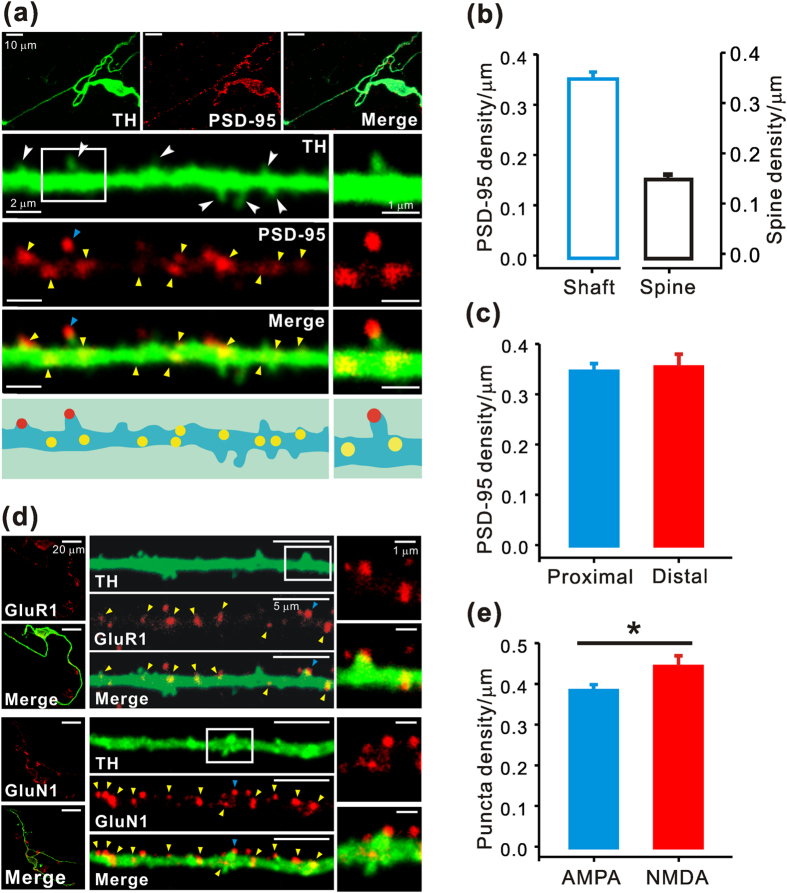
Molecular identification of glutamatergic synapses in dendrites of the SNc dopamine neurons.(a) Double immunostaining with antibodies specific for TH and PSD-95 in very gently dissociated dopamine neurons. Top, TH-positive (green), PSD-95-labeled (red), and overlapped images of a dopamine neuron (merge). Second to fourth lanes, expanded fluorescence images from a representative dendritic region. Bottom, images showing a dendritic shaft and PSD-95 synaptic sites. Arrowheads indicate PSD-95 fluorescence puncta in spines (blue) and shafts (yellow). Right, high-magnification images of the dendritic segment marked by a white box (left) show PSD-95 puncta in both dendritic spines and shafts. (b) PSD-95 density in the dendritic shaft, calculated from 12 dendrites in 10 cells. Error bar indicates SEM. Right, the spine density was redrawn from Fig. 2b,c for comparison. (c) Densities of PSD-95 puncta in the proximal dendritic shafts (<80 μm from the soma; n = 12) and distal dendritic shafts (>80 μm from the soma, n = 12). Error bars indicate SEM. (d) Distribution of AMPA receptors and NMDA receptors in the dendritic spines and shafts of SNc dopamine neurons. Double immunostaining of dissociated dopamine neurons with TH and either GluR1 for AMPAR or GluN1 for NMDAR. TH (green), GluR1 or GluN1 (red), and their overlapped images (merge) are presented. Arrowheads indicate GluR1 and GluN1 fluorescence puncta in spines (blue) and dendritic shafts (yellow). Dendritic regions containing a single spine marked by the white boxes are presented on the right. (e) GluR1 puncta (from 27 dendrites of 18 cells) and GluN1 puncta (from 17 dendrites of 10 cells) measured only in the dendritic shaft. *p < 0.05 by unpaired t-tests. Error bars indicate SEM.